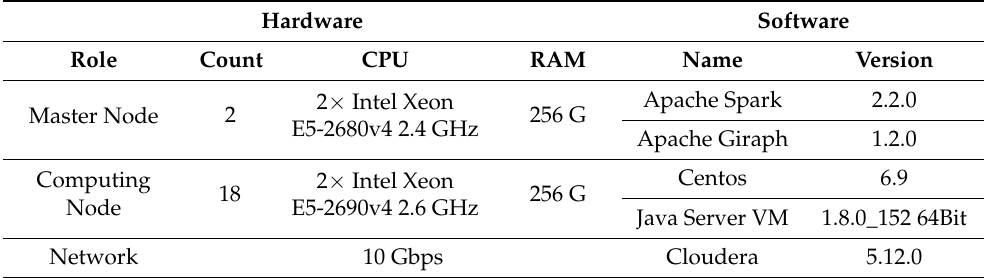
Table 3. Computing